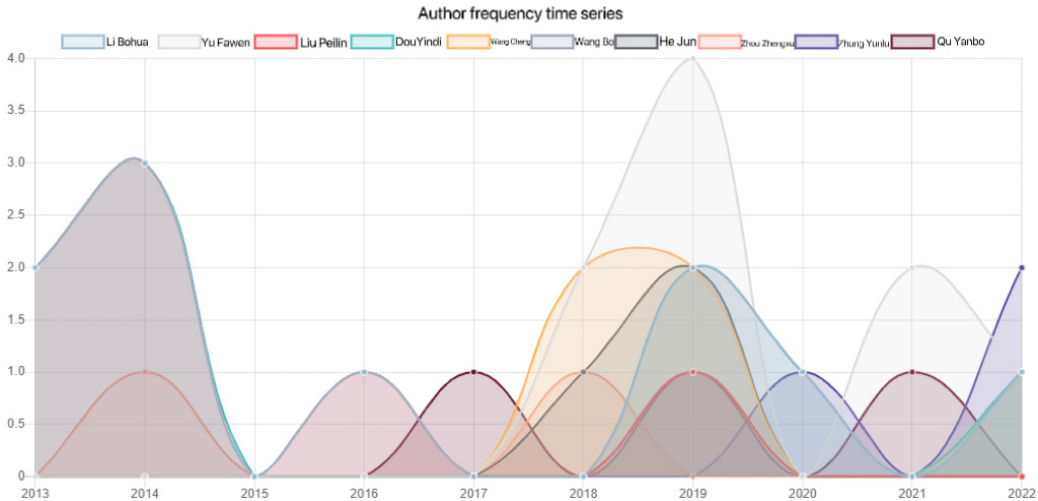
Figure 3. Author publication frequency in relation to rural human settlement environment research.